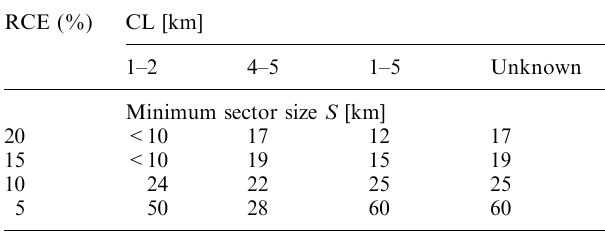
Table 2. Minimum sector sizes S required to avoid RCE exceeding a given maximum. If heights of cloud base and top are unknown the maximum of the S values obtained for the three di(cid:128)erent cloud layers (CL = 1–2 km, CL = 4–5 km, CL = 1–5 km) is